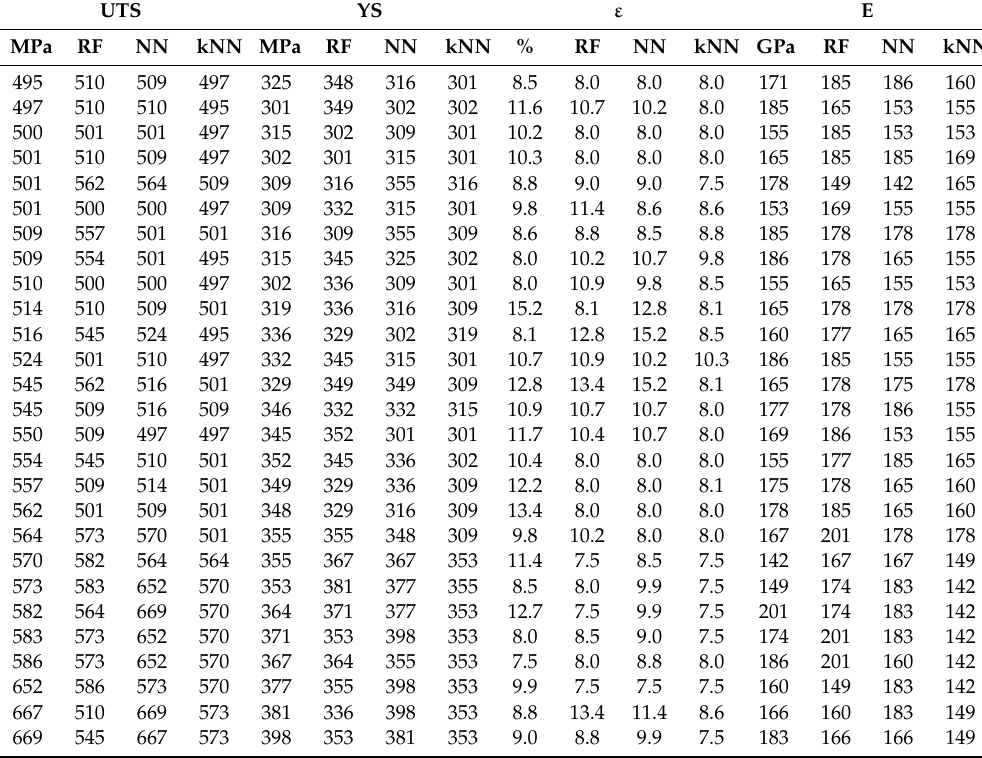
Table A3. Prediction of mechanical properties of Spheroidal Graphite Iron